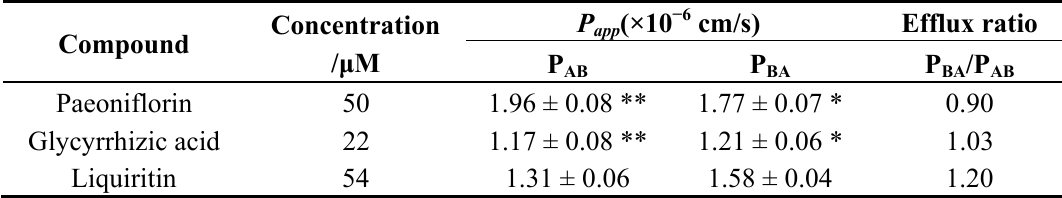
Table 3. Permeability of paeoniflorin, glycyrrhizic acid, liquiritin in the mixture of Shaoyao-Gancao